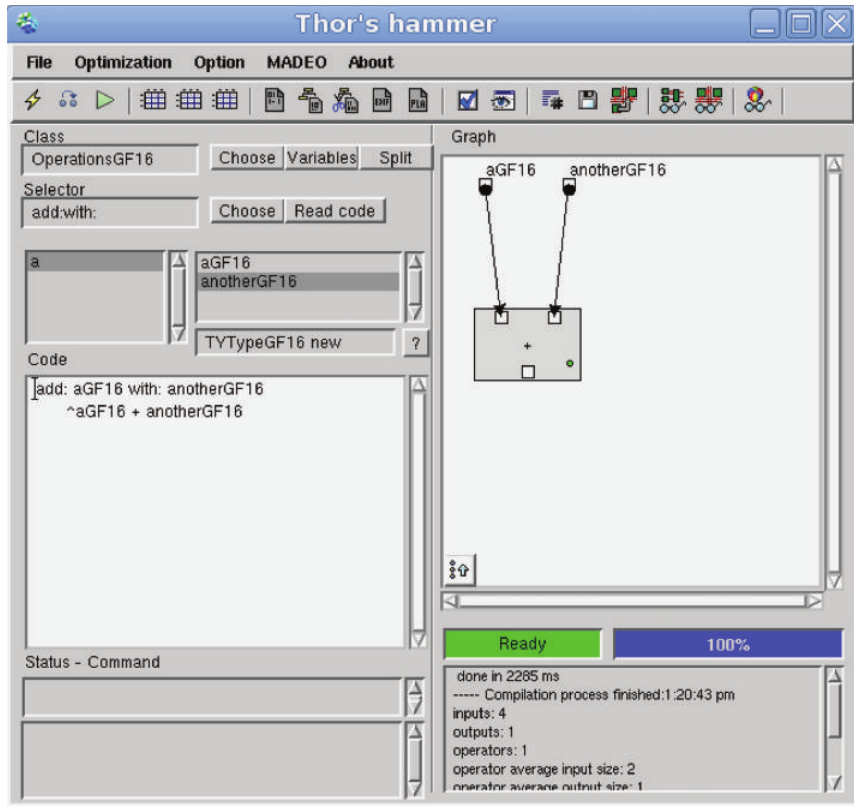
Figure 7: Specification of a GF16